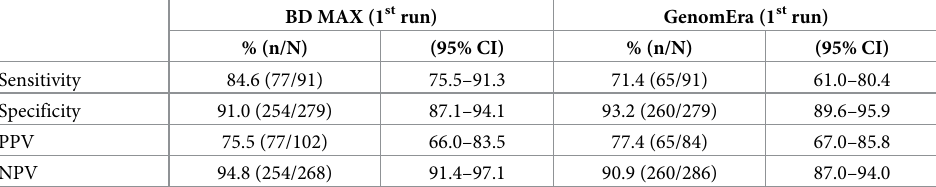
Table 2. Comparison of the performance characteristics.